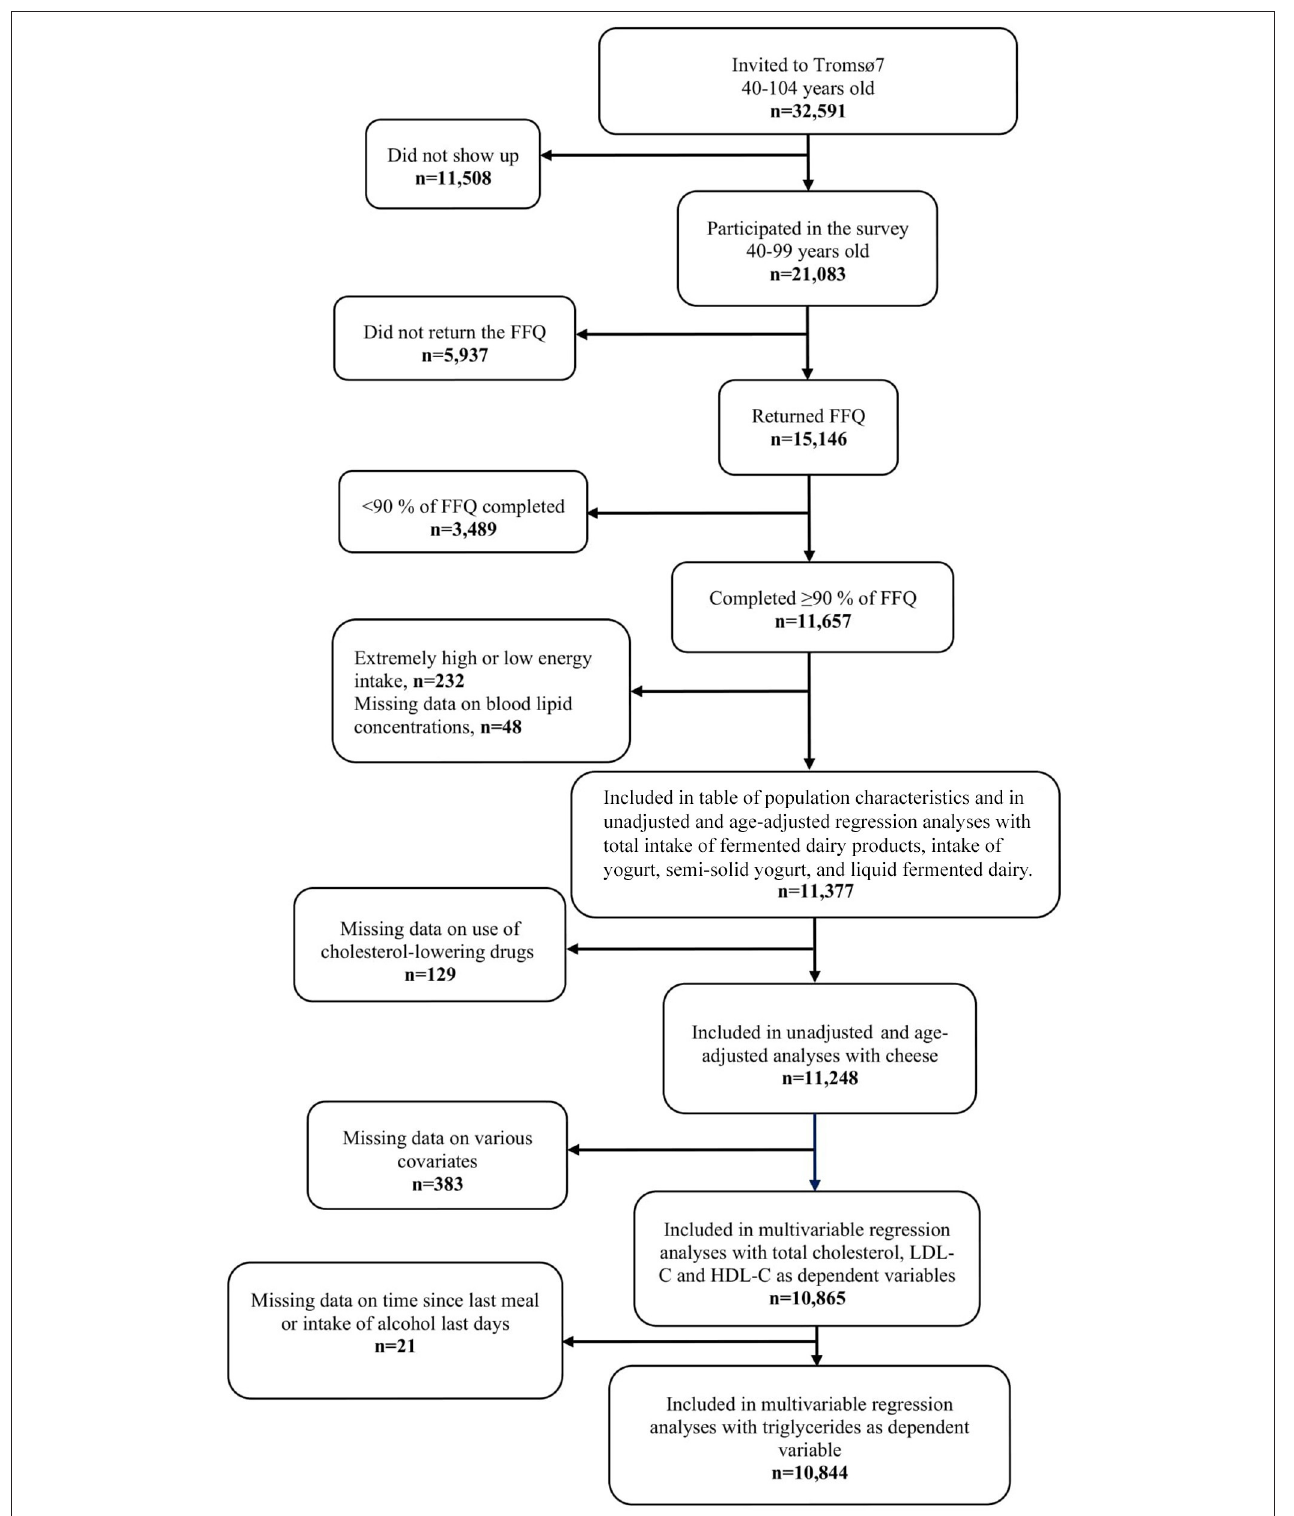
FIGURE 1 | Flow chart of the study population. FFQ, food frequency questionnaire; LDL-C, low-density lipoprotein cholesterol; HDL-C, high-density lipoprotein cholesterol.